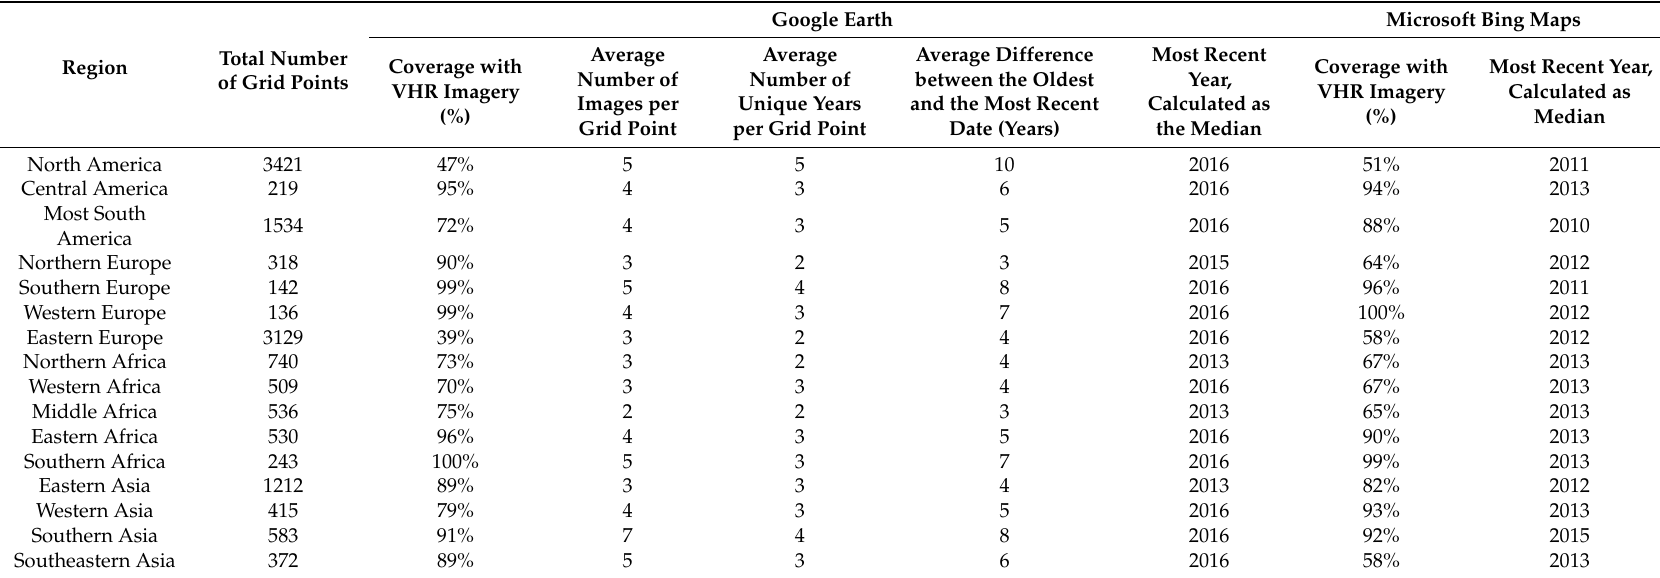
Table 2. The availability of VHR satellite imagery (<5 m resolution) from Google Earth and Microsoft Bing Maps by